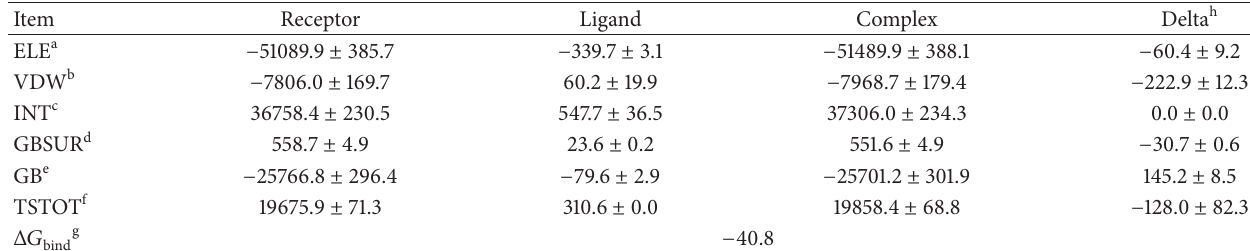
Table 1: Energy components contributing to the binding free energy